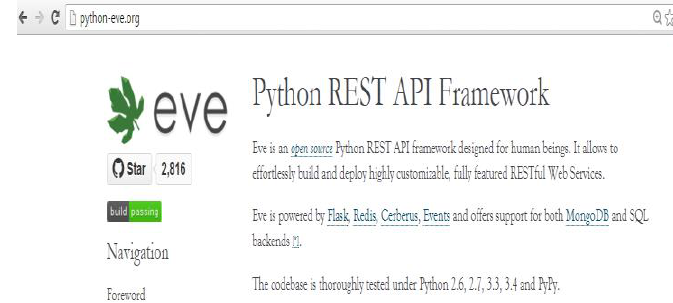
Figure 15 – Eve python ReST API framework